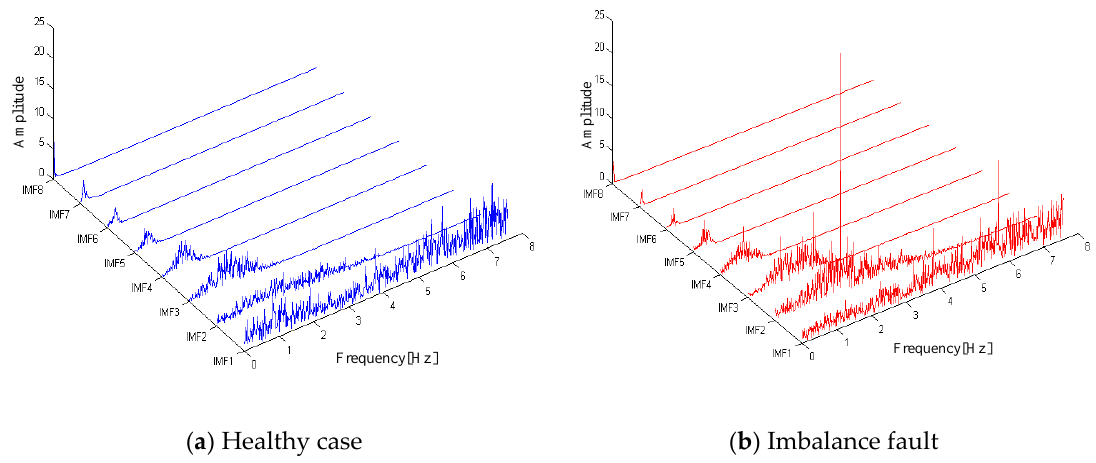
Figure 13. Proposed detection result under strong interference conditions.